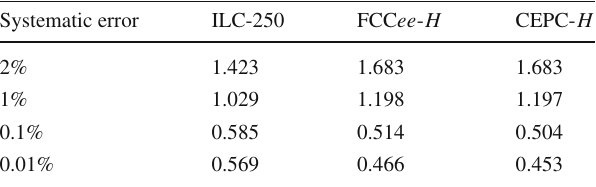
Table 4 95% CL upper bounds for | a NP τ | expected from the Z H mode of various future e − e + colliders Systematic error